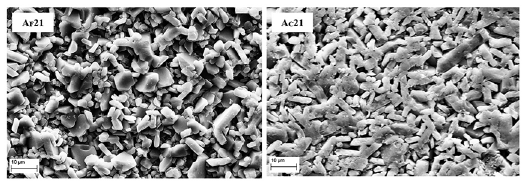
21 (1,470 ºC/3 h, F